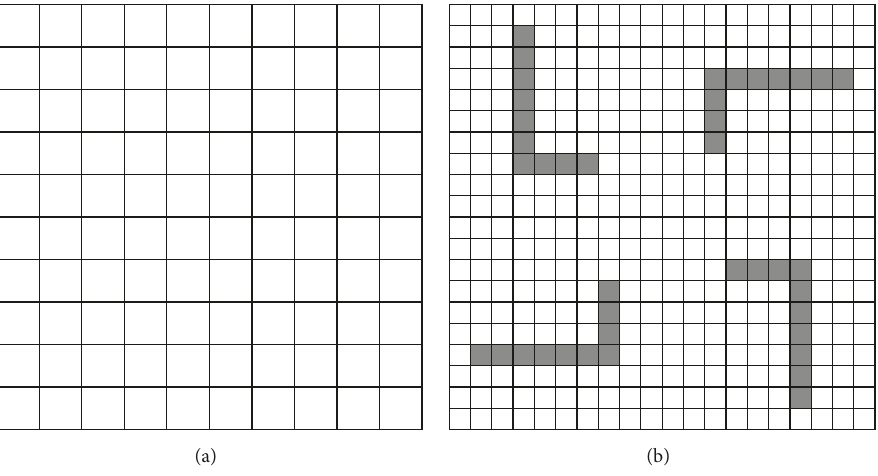
Figure 1: (a) Discrete grid model and (b) the rotational symmetrical layer.